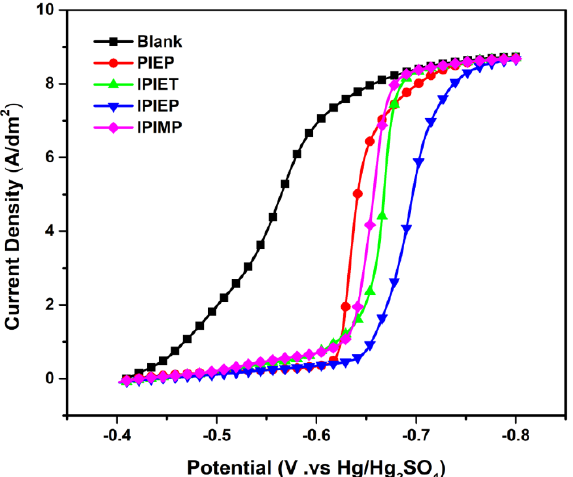
Figure 2. Potentiodynamic polarization curves related to 5 mg/L oligomers in the base electrolyte. The electrode rotation speed is 1500 rpm.